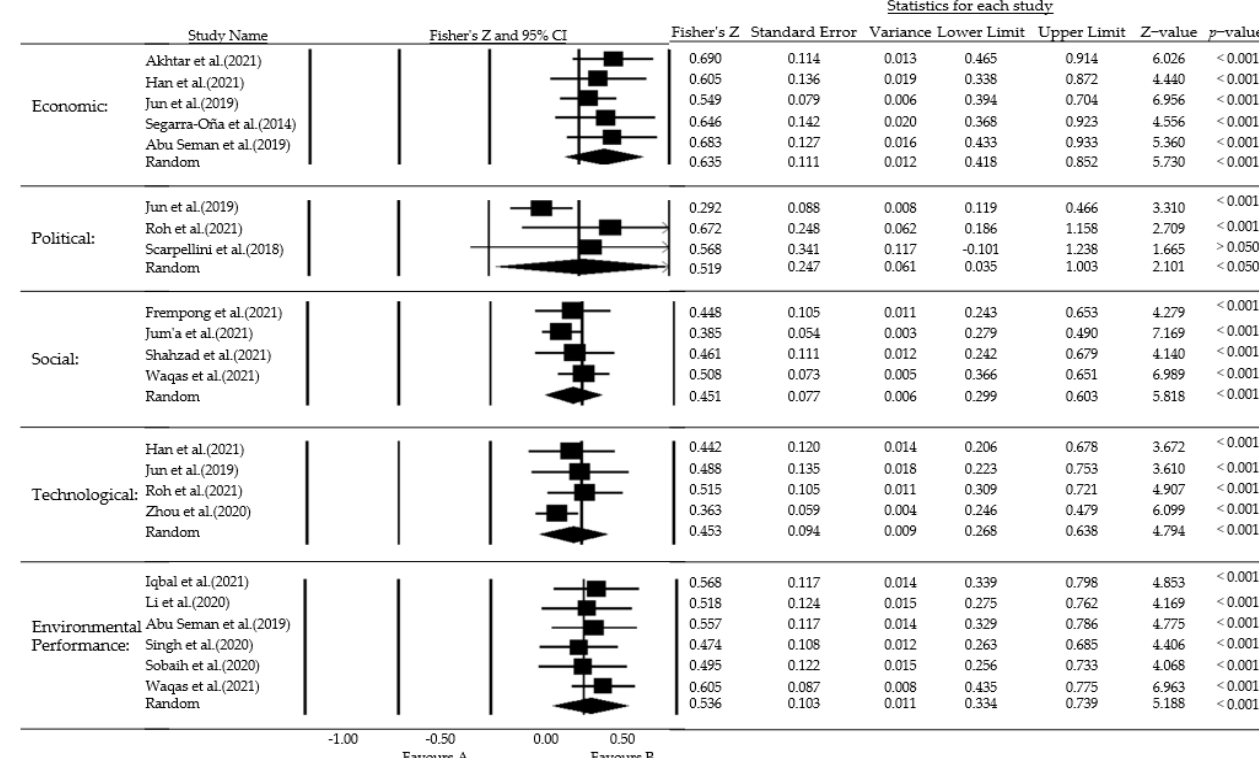
Figure 6. Sensitivity analysis of each dimension [30,45,46,57,60,74 – 84].